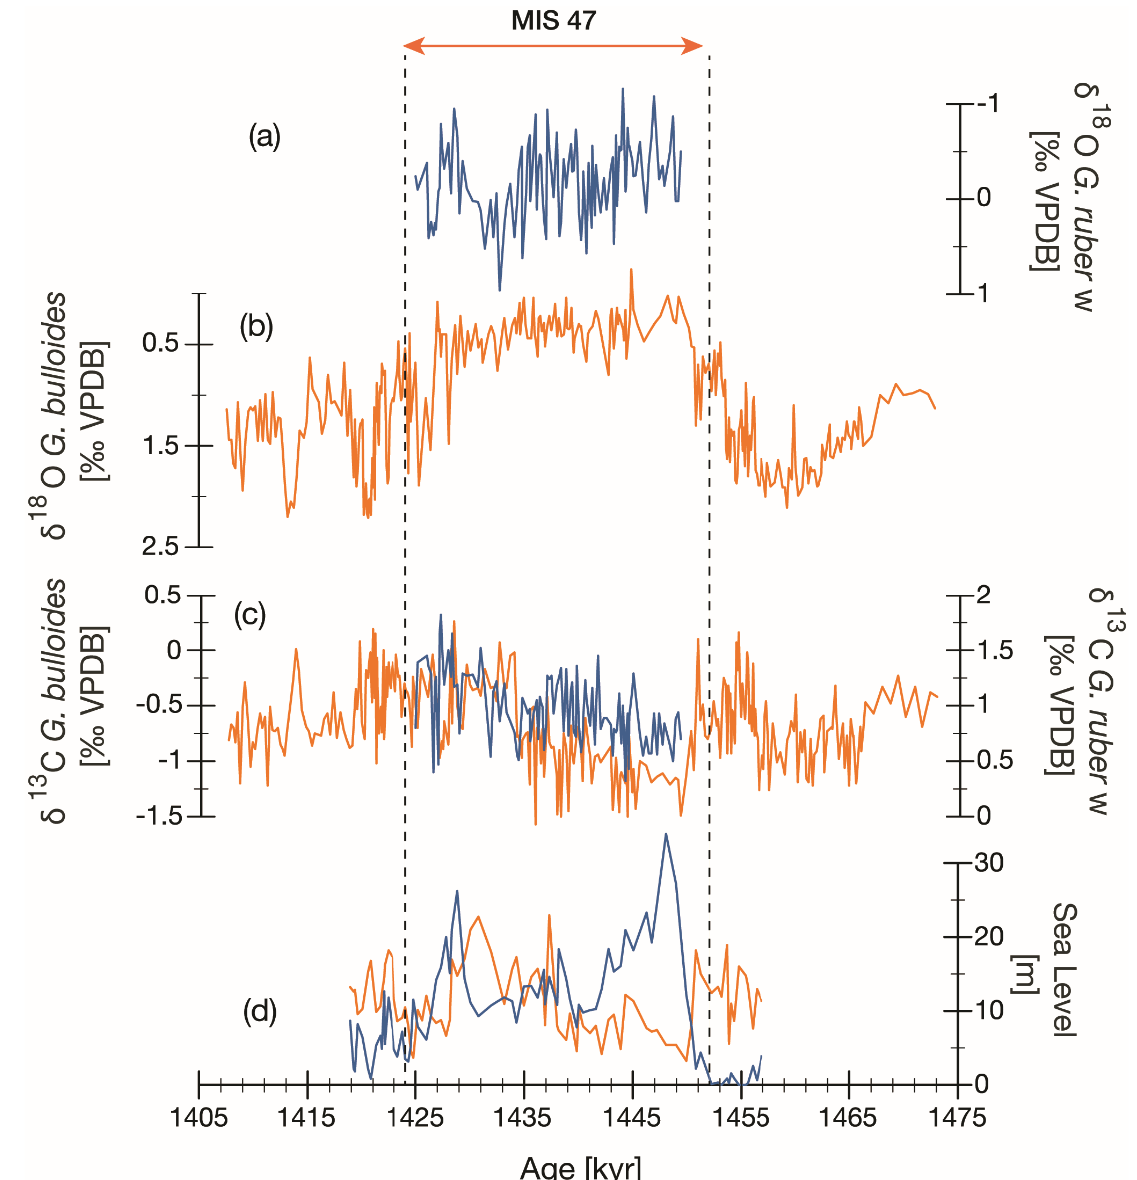
Figure 4. Planktonic foraminifera stable isotope records of IODP Site U1387. ( a ) G. ruber white δ 18 O record; ( b ) G. bulloides δ 18 O record; ( c ) δ 13 C records of G. ruber white (blue) and G. bulloides (orange); ( d ) percentage contributions of G. ruber white (blue) and G. bulloides (orange) to the planktonic foraminifera fauna.